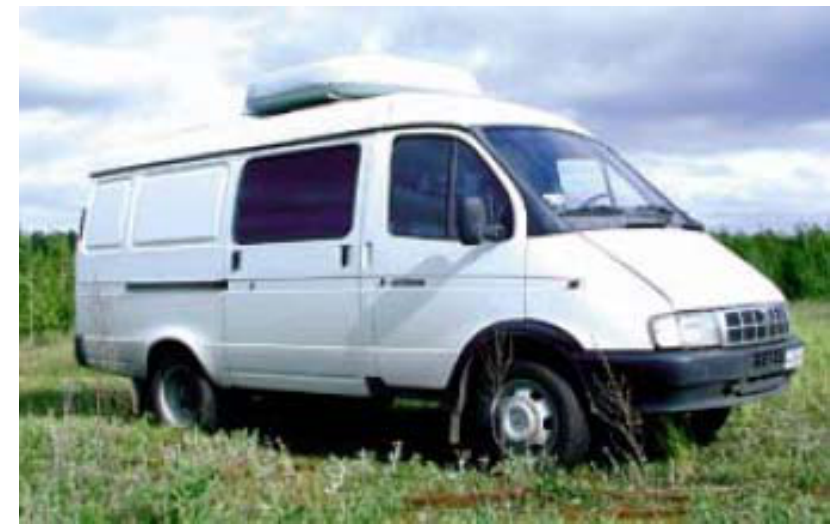
Figure 2. Mobile radio direction finding system of the “Article” family.